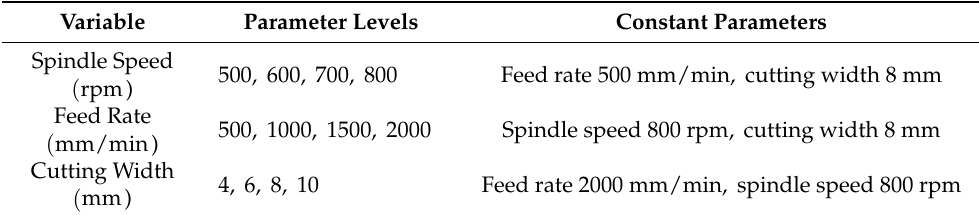
Table 3. Control variables of experimental